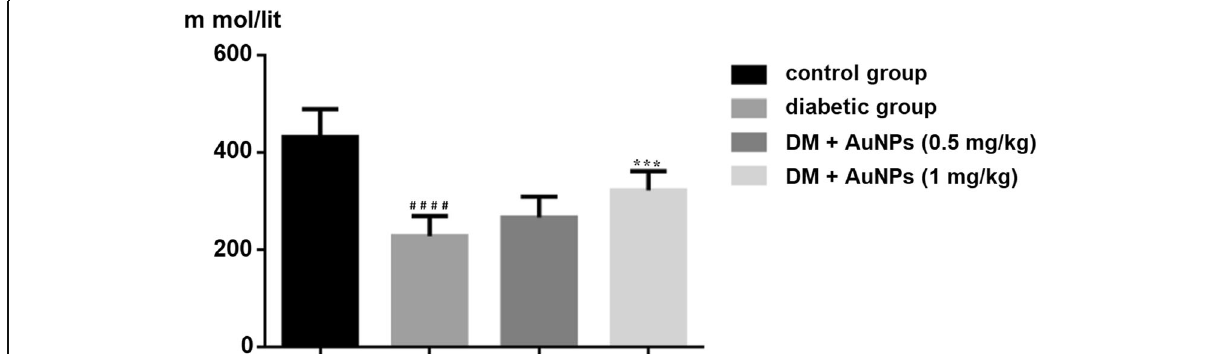
Fig. 7 Effect of AuNPs on FRAP experimental groups of rats after 21 days treatment. Data are reported to mean ± SD of 5rats in each group. *, **,***,and****represent statistically significant differences from Diabetic group at p < 0.05, 0.01,0.001 and 0.0001, respectively. #, ##, ###, and ####represents statistically significant difference from control group at p < 0.05, 0.01,0.001 and 0.0001, respectively